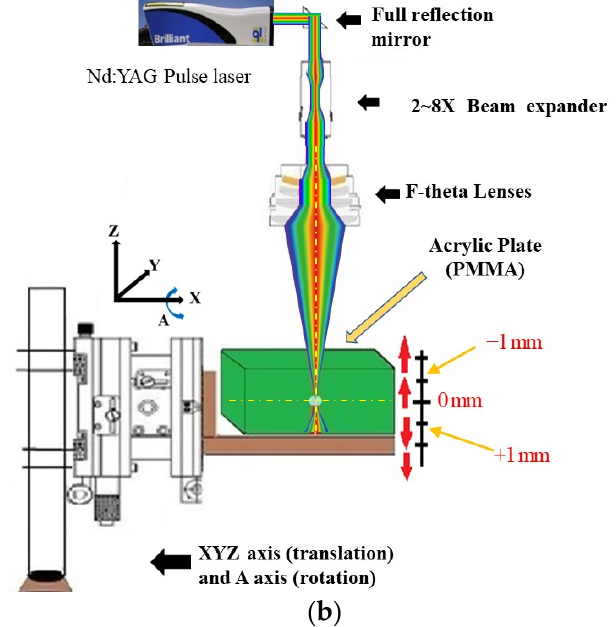
Figure 1. Experimental setup: ( a ) laser energy and beam profile measurement, and ( b ) schematic of laser beam alignment and focusing position adjustment.